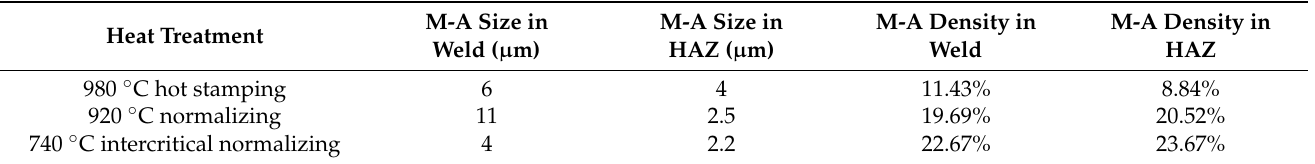
Figure 6. The M − A of the weld joint after hot stamping simulation at 980 ◦ C, normalizing at 920 ◦ C, intercritical normalizing at 740 ◦ C; Simulation − weld ( a )and HAZ ( b ); normalizing − weld ( c ) and HAZ ( d ); intercritical normalizing − weld ( e ) and HAZ ( f ). M-A constituent size and density for 980 ◦ C for 1 h, 920 ◦ C for 1 h (normalizing), 740 ◦ C for 1 h (intercritical